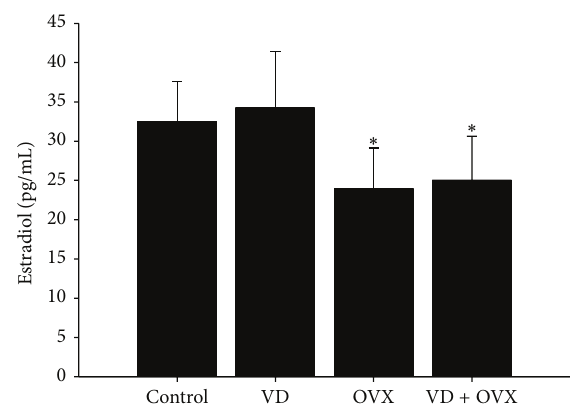
Figure 2: Plasmas estradiol in the different groups. Each bar represents the mean ± SEM of six individual mice. ∗ 𝑃 < 0.05 compared to control group.